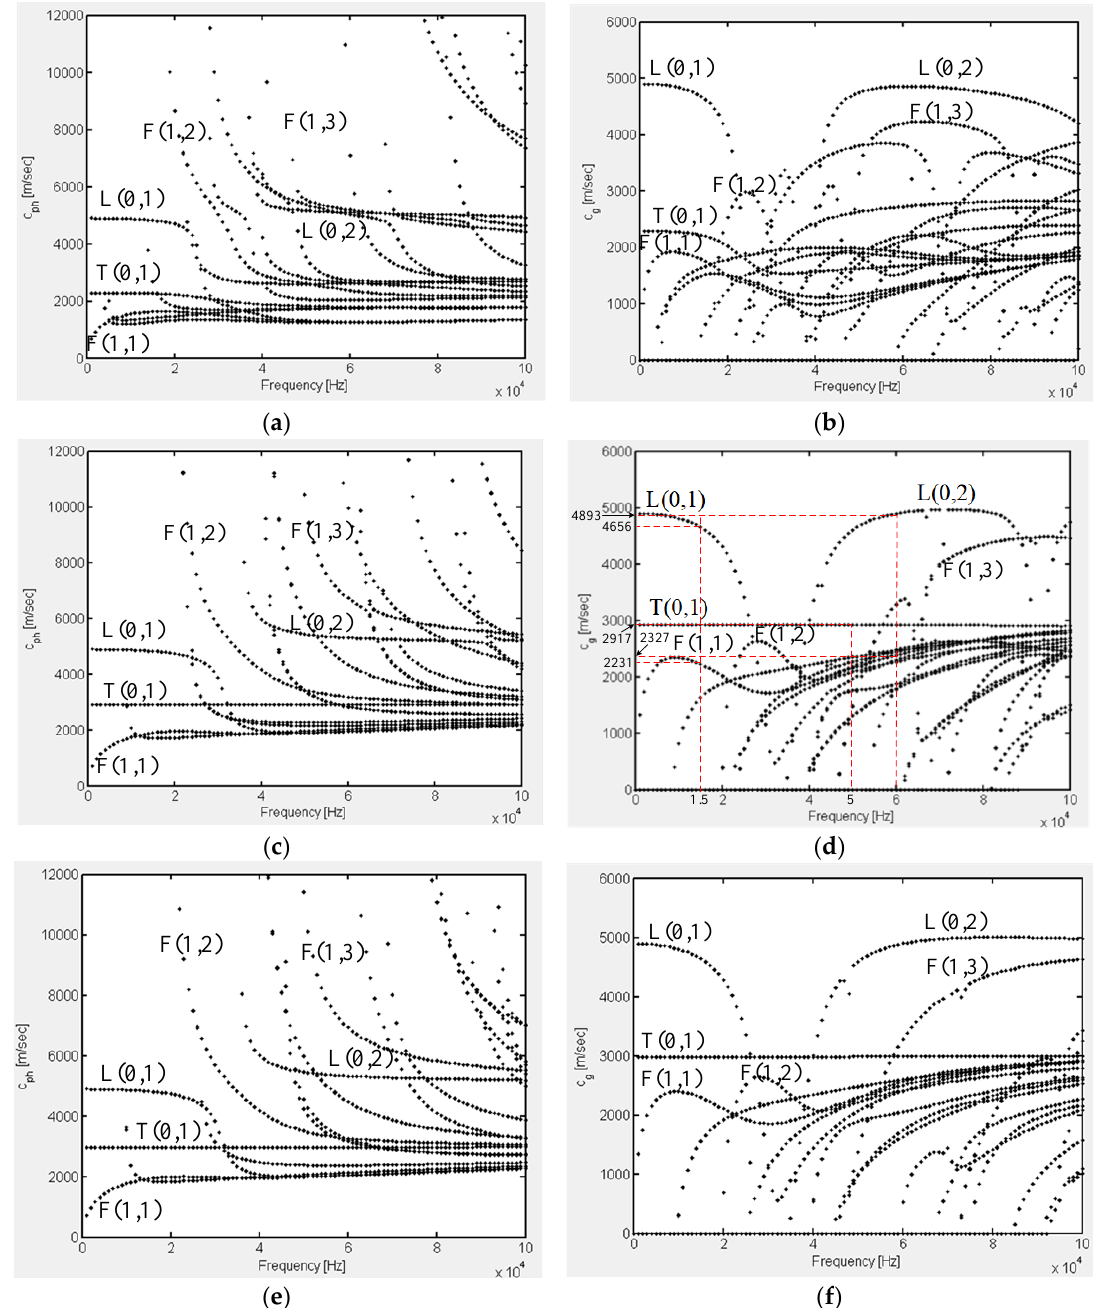
Figure 4. Phase velocity dispersion curves of: ( a ) a square drill pipe, ( c ) a hexagonal drill pipe, and ( e ) an octagonal drill pipe; and group velocity dispersion curves of: ( b ) a square drill pipe, ( d ) a hexagonal drill pipe, and ( f ) an octagonal drill pipe.